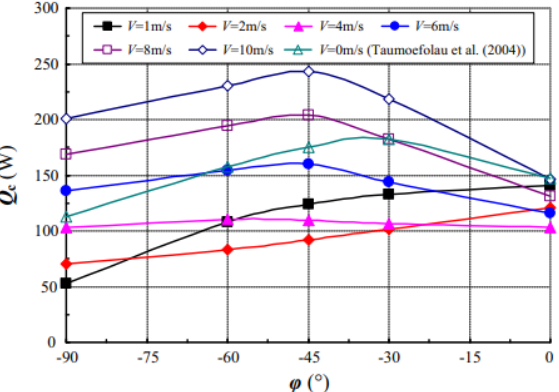
for various V at = 90° and Tw = 923 K. Reprinted with permis- 𝜑𝜑 𝛼𝛼